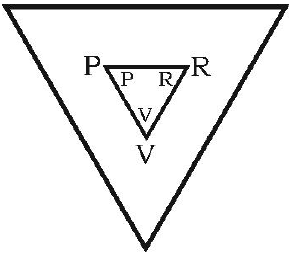
Figure 12: The Redecision Triangle.